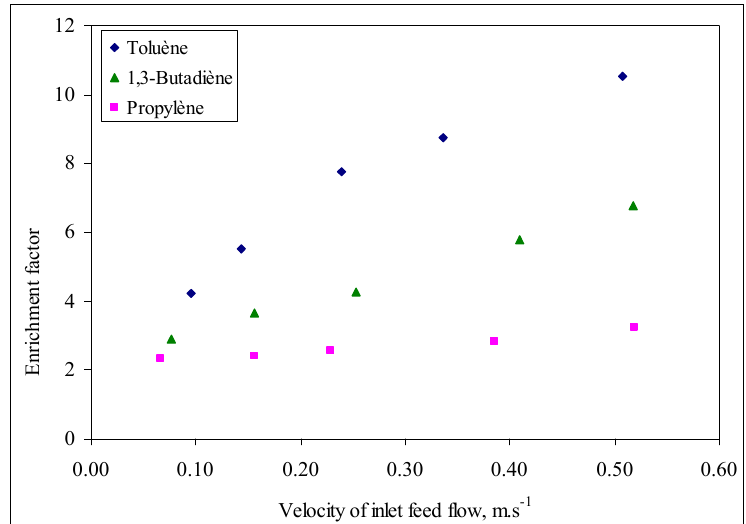
Figure 3. Effect of feed velocity on enrichment factor at constant feed molar fraction: 1.5% for toluene and 1.7% for 1,3-butadiene and